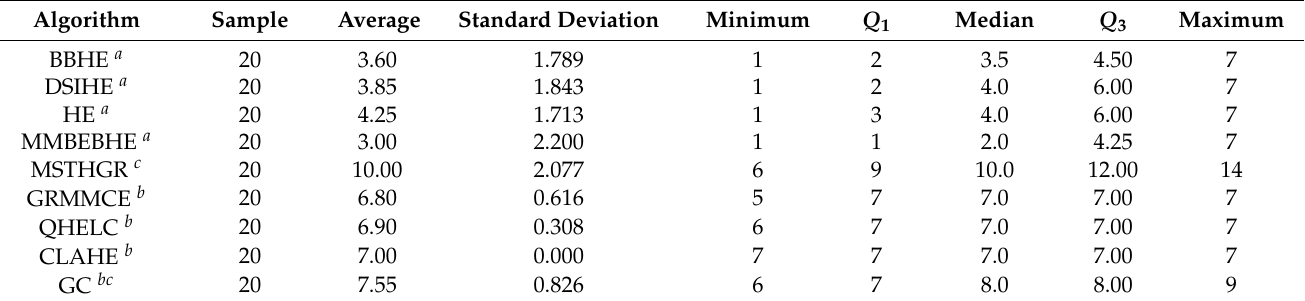
Table 3. Descriptive statistics of the sum of scores according to the enhancement algorithm applied.